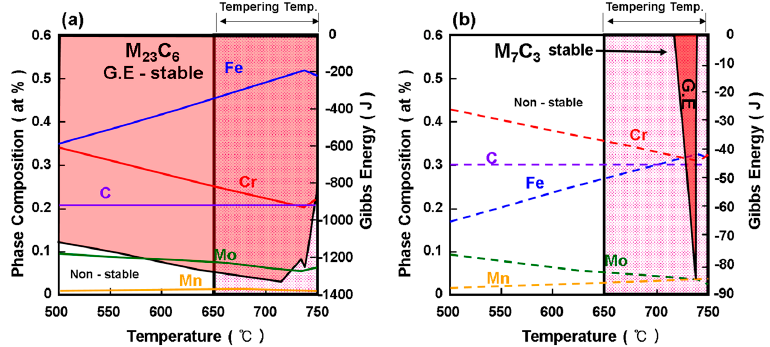
Figure 8. Calculated phase composition and Gibbs energy of model A: ( a ) M 23 C 6 on the model A phase diagram; ( b ) M 7 C 3 on the model A phase diagram.